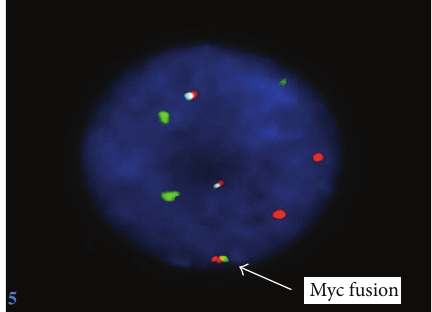
Figure 5: Interphase FISH analysis showing a normal chromosome 9 and 22, MYC gene translocation, and an extra red MYC signal translocated onto chromosome 7.